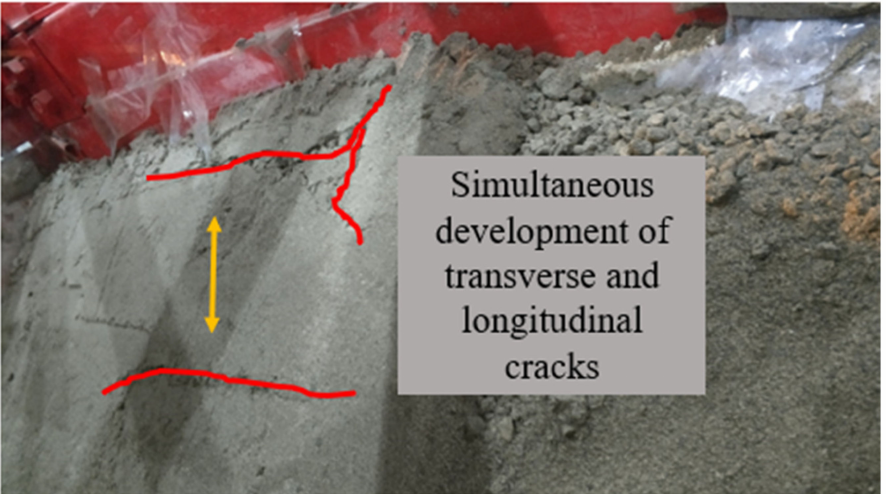
Figure 10. Slope top after 0.5 g sine wave loading.